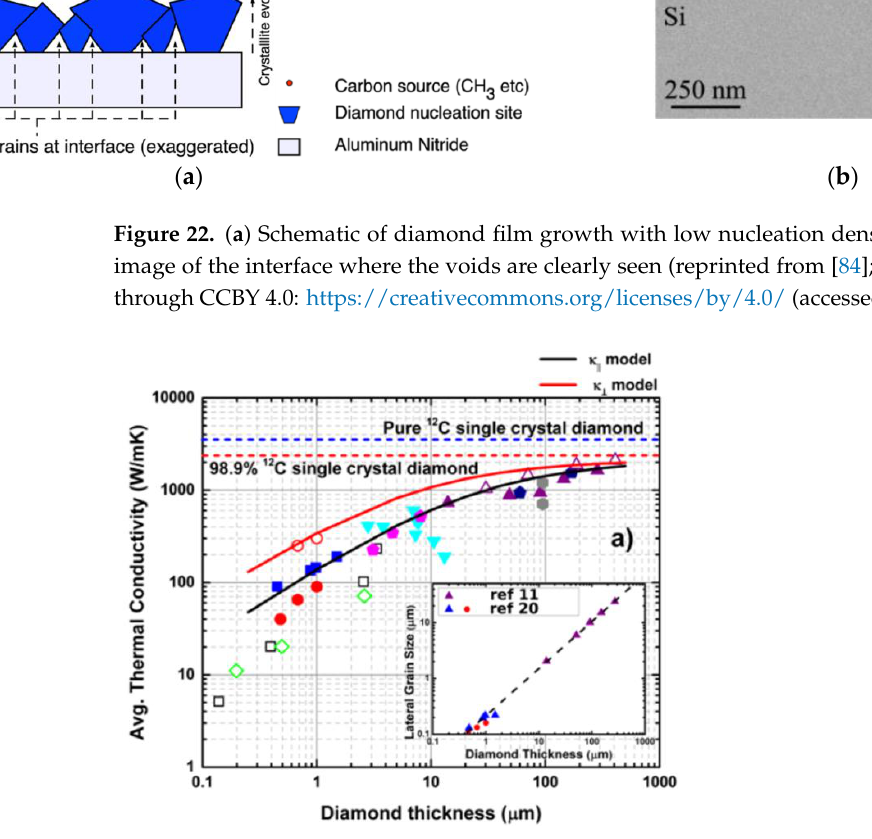
Figure 23. Evolution of in-plane and out-of-plane κ with diamond film thickness (© 2016 IEEE. Reprinted, with permission, from J. Anaya, et al., “Thermal management of GaN-on-diamond high electron mobility transistors: Effect of the nanostructure in the diamond near nucleation region,” in 15th IEEE Intersociety Conference on Thermal and Thermomechanical Phenomena in Electronic Systems (ITherm), 2016, pp. 1558 1 – 8 [175]).